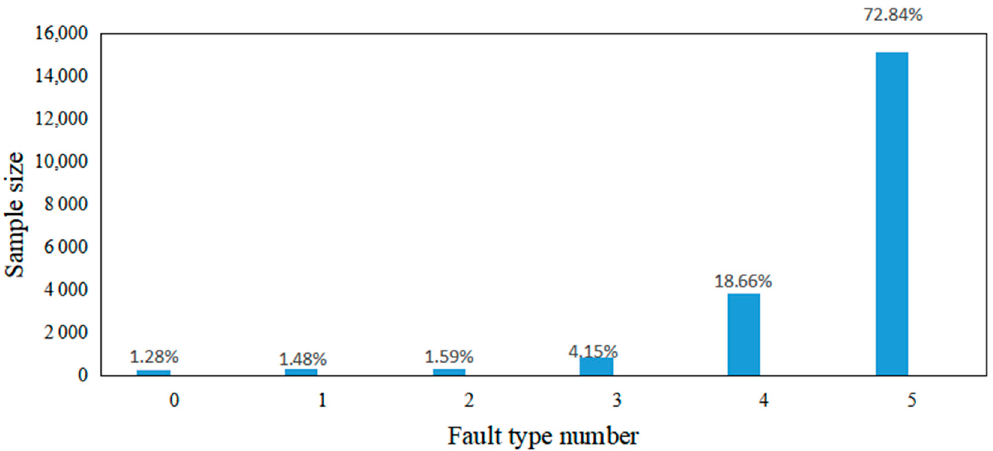
Figure 4. Histogram of the distribution of sample sizes for different fault types.